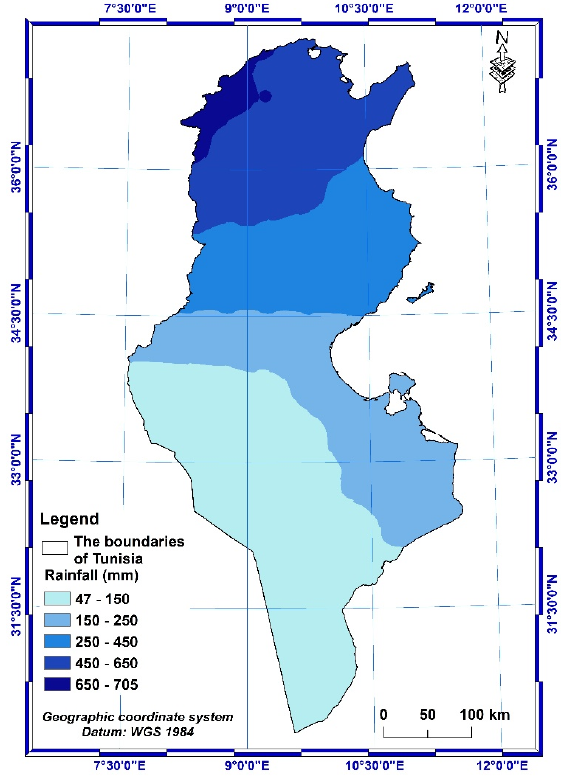
Figure 6. Map of mean annual rainfall in Tunisia.